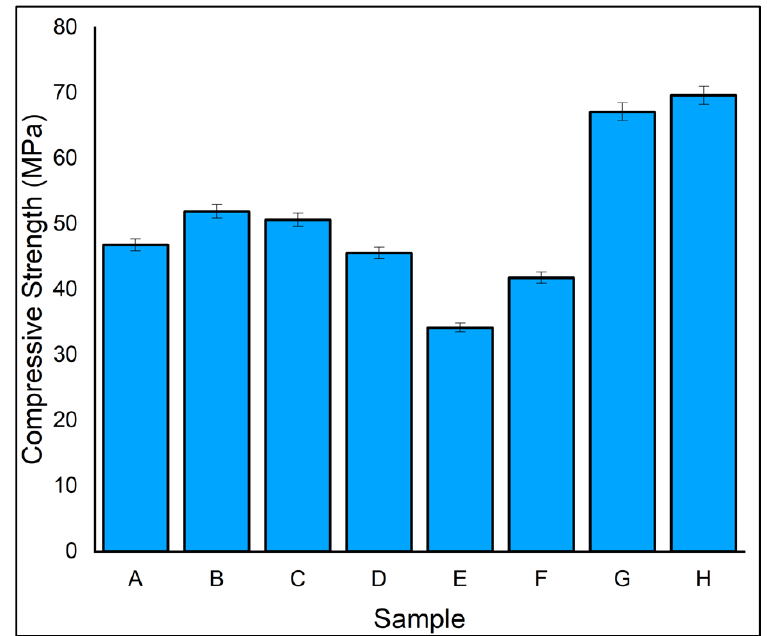
Figure 10. Compressive strength of specimen.